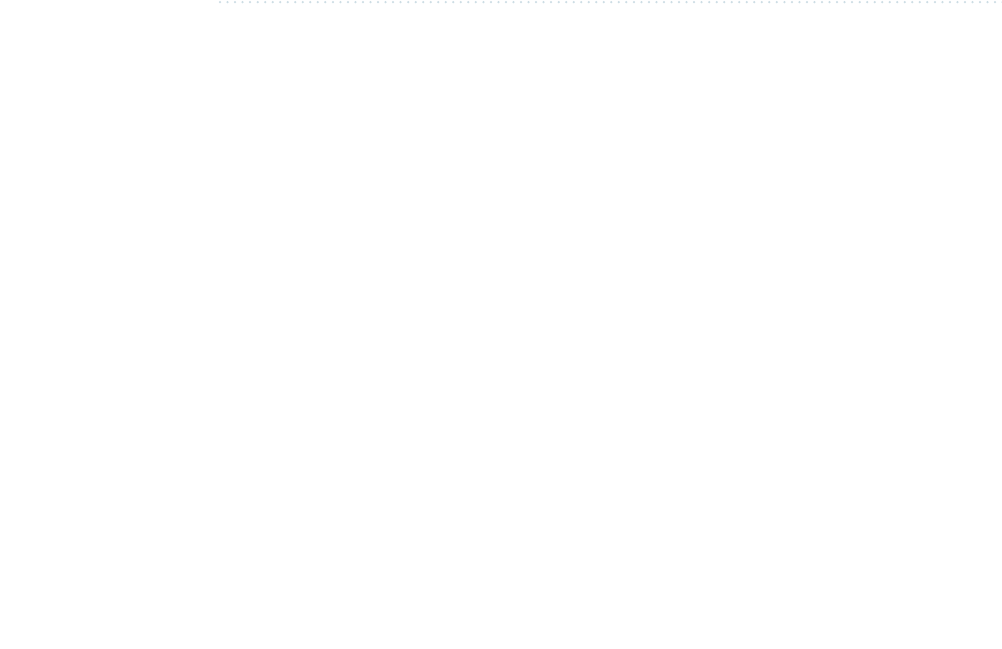
Figure 5. Protein–protein interaction (PPI) network of PARD3-associated